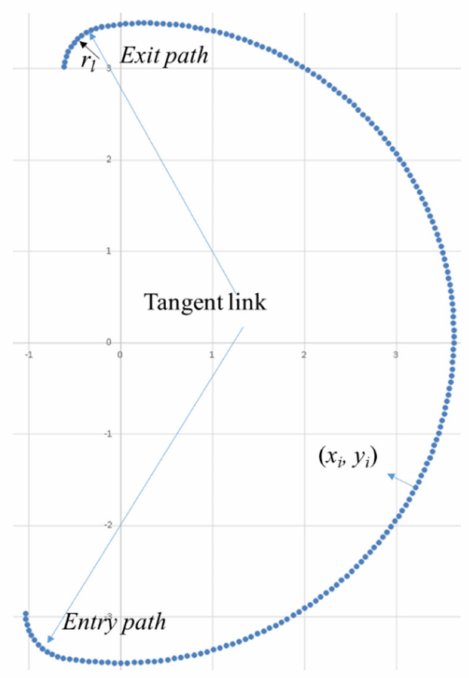
Figure 15. Trochoidal path step.